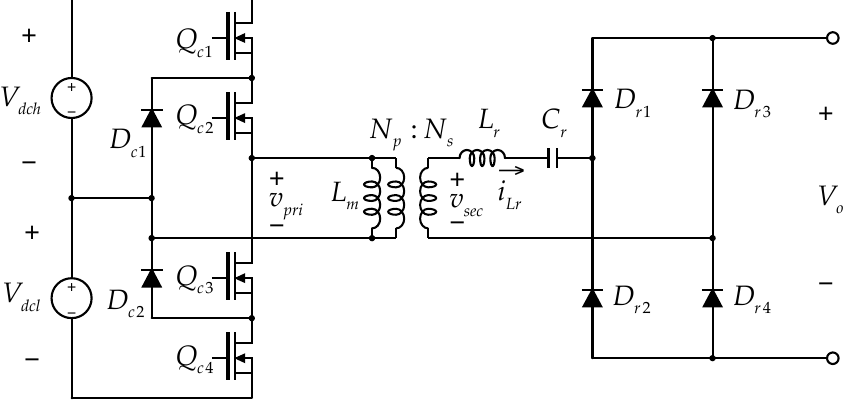
Figure 7. Circuit configuration of the LLC converter. Energies 2018 , 11 , 201